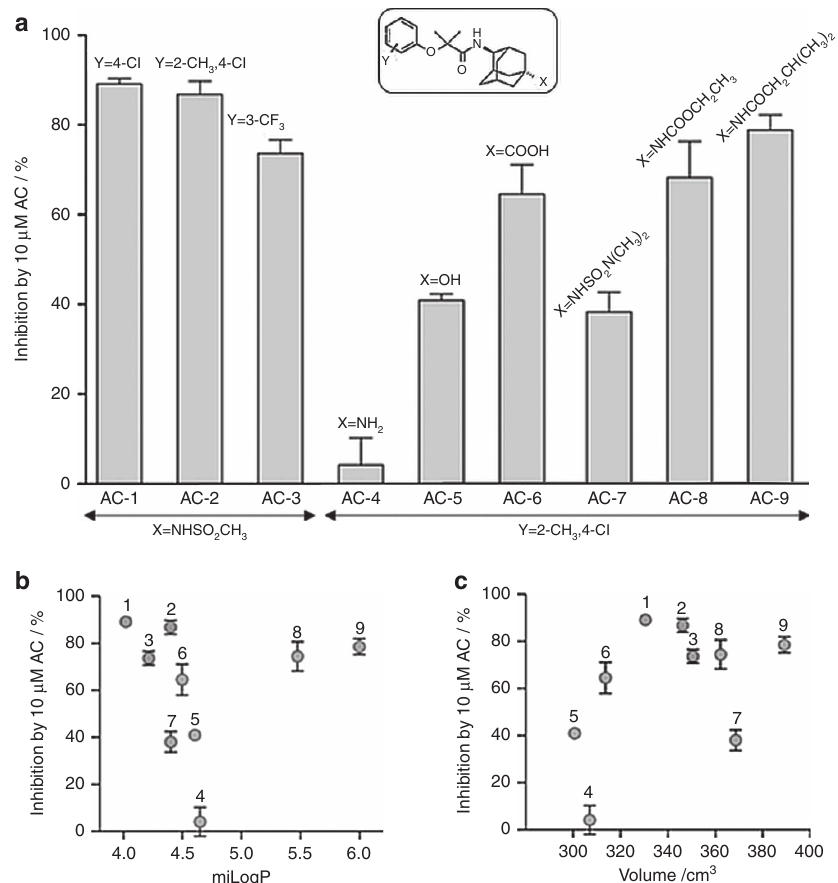
Figure 4 | Structure activity relationship of adamantane compounds. ( a ) Inhibitory effect of different AC derivatives (10 m M) on Kv7.1/KCNE1 channels. Chemical modifications at both ends of AC-1 were investigated as indicated. Inhibition was determined as percent change in current amplitude at the end